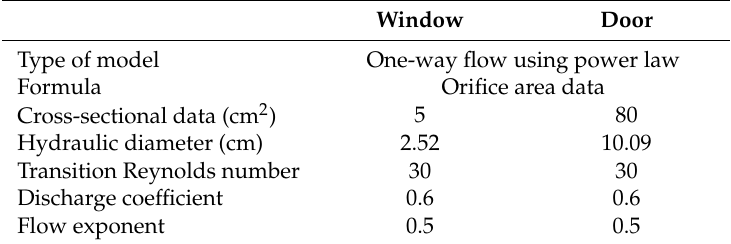
Table 2. Model summary of parameters for windows and doors in both dwellings.